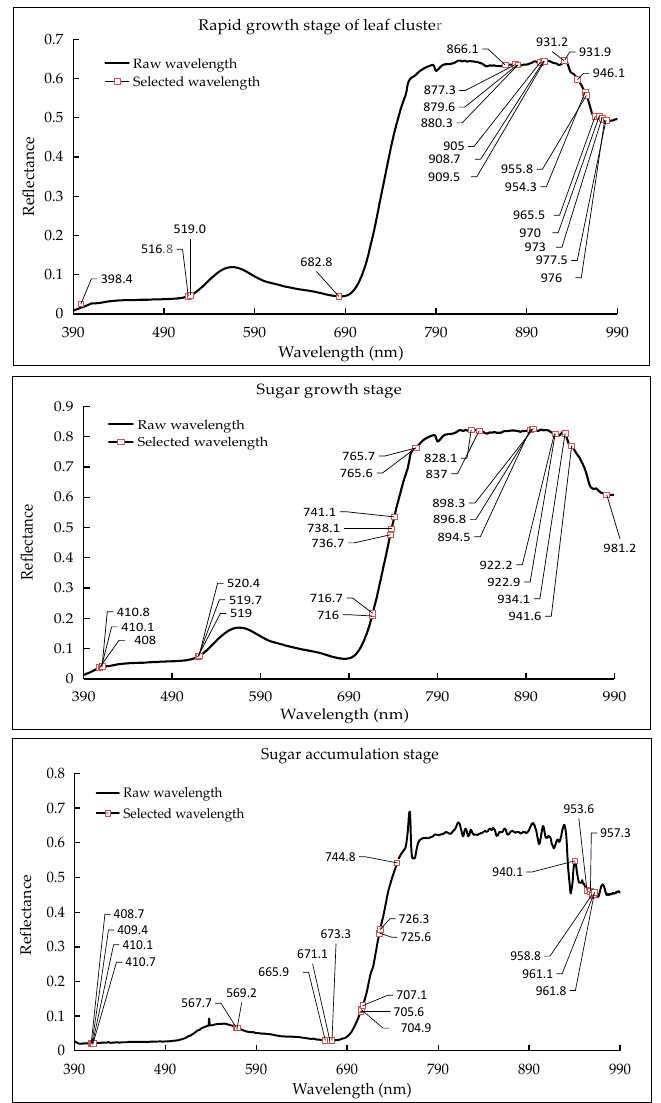
Figure 8. The selected key wavelengths marked by a square for the three studies growth stages, resulted from competitive adaptive reweighted sampling algorithm (CARS).